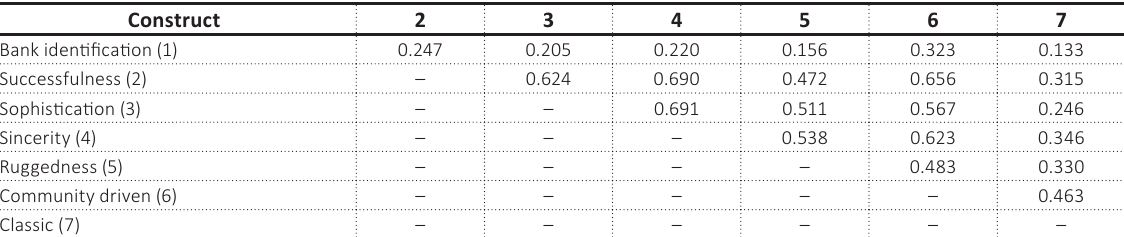
Table 4. Correlation